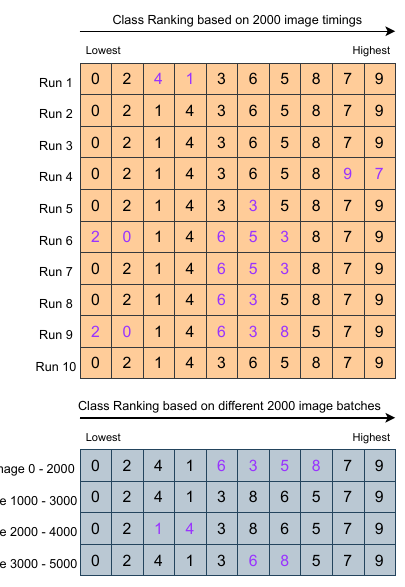
Figure 17: (top) Rank analysis of classes over 10 runs after summing the timing of 2000 images of each class label. (bottom) Rank analysis of classes with 4 different subsets of 2000 images from each